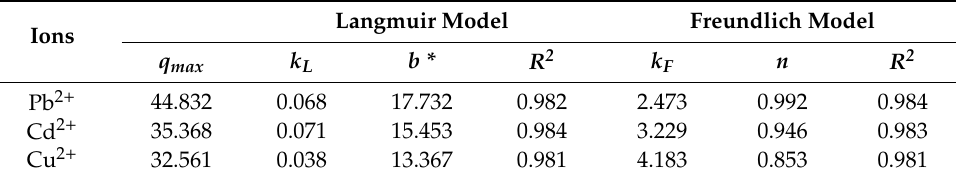
Table 5. Langmuir model and Freundlich model